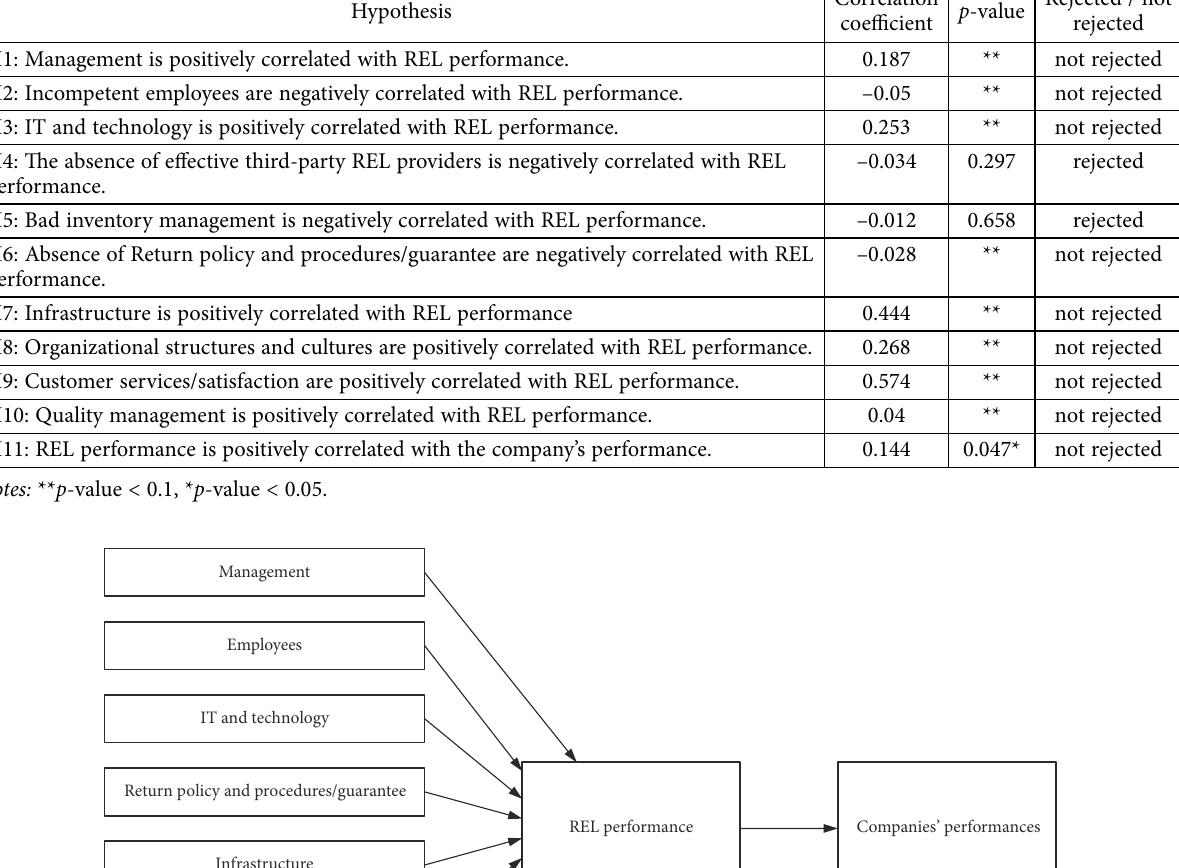
Table 10. Formulated hypothesis with their corresponding results (source: compiled by authors 2020) Hypothesis